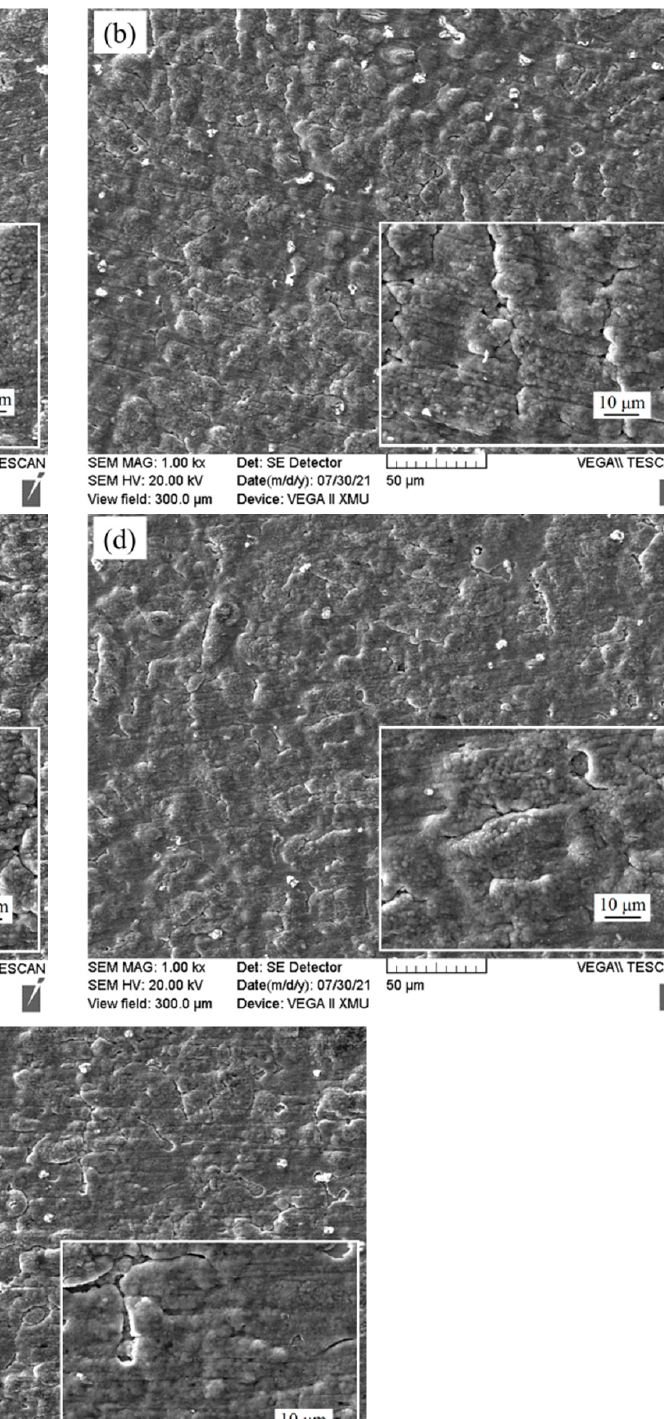
Figure 10. The granular oxide distribution on the oxidization surface of Fe-25Mn-9Al-8Ni-1C-xTi alloy. ( a ) 0 wt.% Ti; ( b ) 0.1 wt.% Ti; ( c ) 0.2 wt.% Ti; ( d ) 0.3 wt.% Ti; ( e ) 0.4 wt.% Ti. The surface morphology of Fe-25Mn-9Al-8Ni-1C-xTi alloy oxidized for 200 h is pre- sent in Figure 11. It can be seen from Figure 11 that the oxide surface layer is mainly com- posed of two forms of substances. One is a continuously distributed gray-black substance,